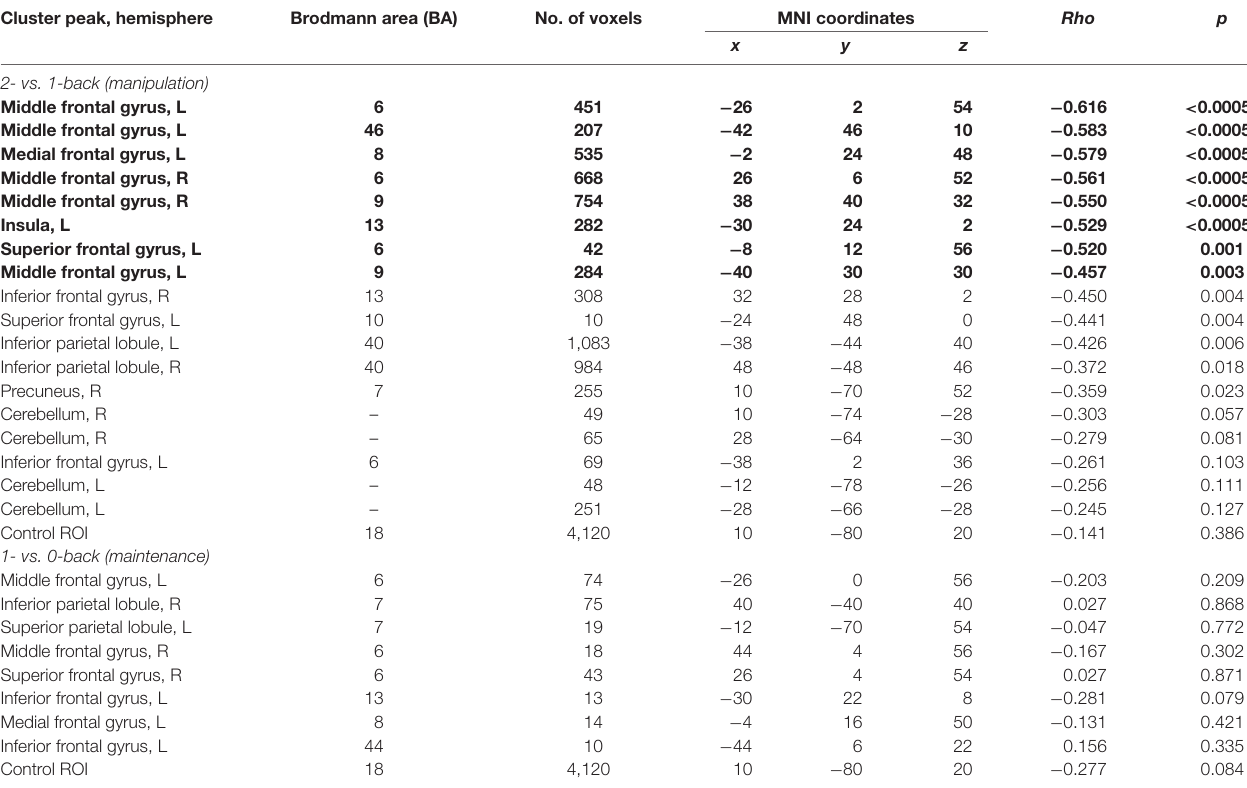
TABLE 2 | Correlations ( rho and p -values) between temporal information processing (TIP) and brain activity in regions of interest (ROIs) reflecting working memory (WM) manipulation (2- vs. 1-back) and maintenance (1- vs. 0-back). Cluster peak, hemisphere Brodmann area (BA) No. of